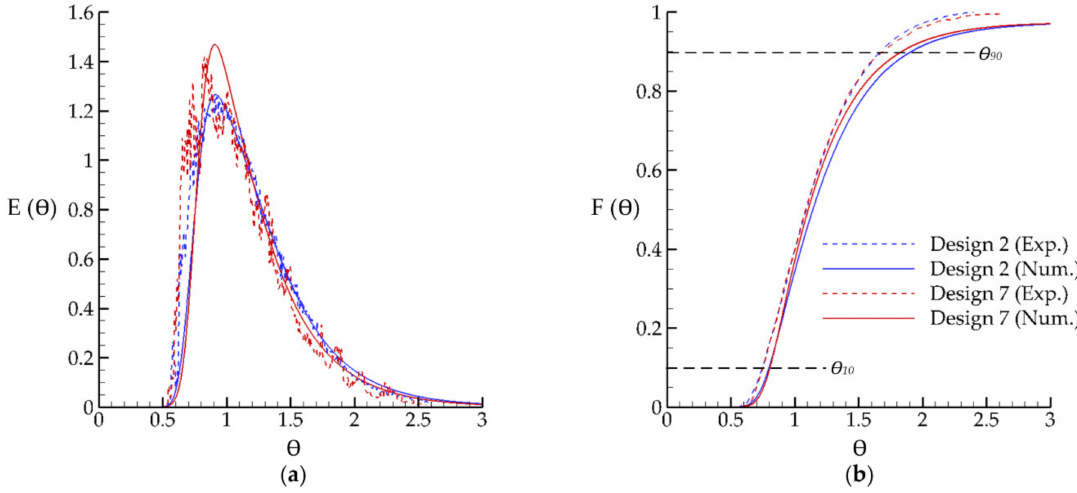
Figure 6. Comparison of numerical and experimental tracer results for Design 2 and Design 7: ( a ) RTD; ( b )